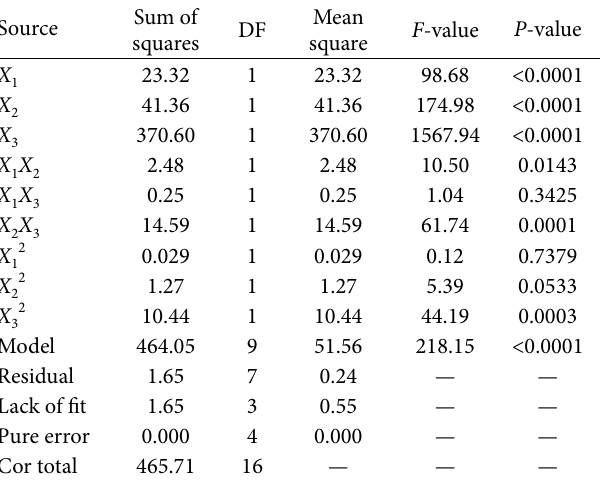
Table 3: Results of analysis of variance ( ANOVA ) for DEs.